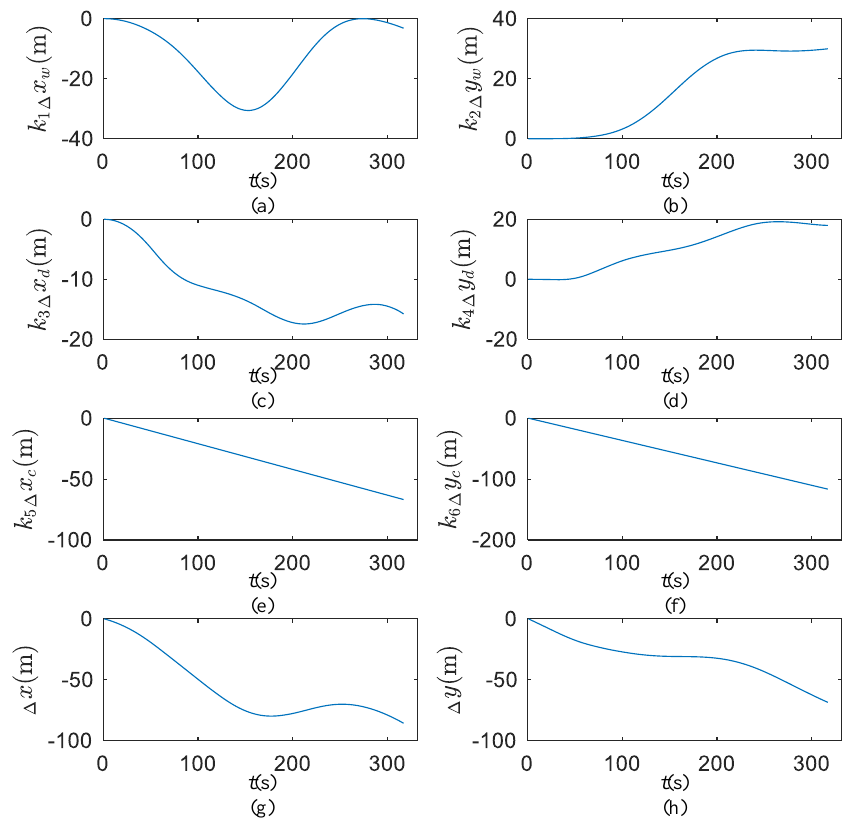
Figure 8. Wind, waves and sea surface currents induced earth-centered earth-fixed (ECEF) distances of + 20 ◦ turning circle test. ( a ) Transverse drift distance induced by wind; ( b ) longitude drift distance induced by wind; ( c ) transverse drift distance induced by wave; ( d ) longitude drift distance induced by wave; ( e ) transverse drift distance induced by current; ( f ) longitude drift distance induced by current; ( g ) transverse resultant drift distance induced by wind, wave and current; ( h ) longitude resultant drift distance induced by wind, wave and current.